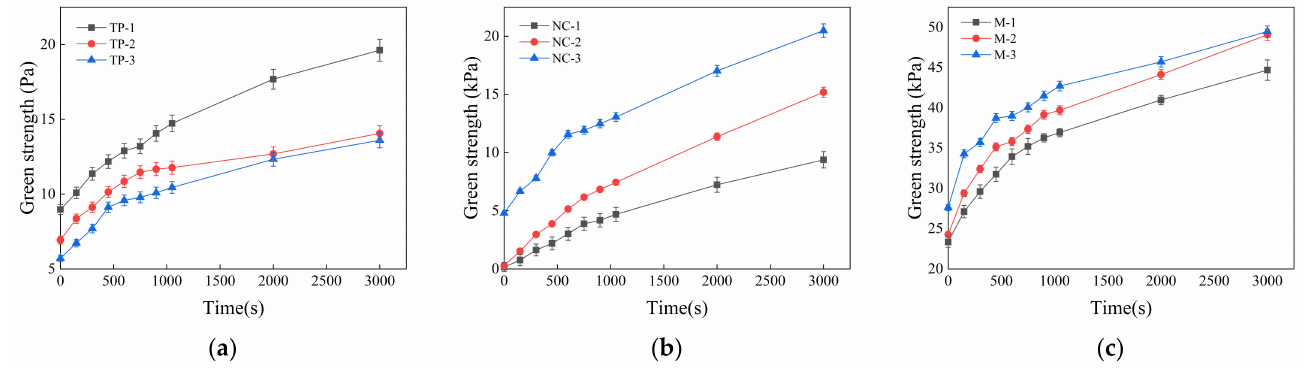
Figure 14. The green strength development with time of printed materials with ( a ) single-doped TP, ( b ) doped NC and 3‰ PCE and ( c ) double-doped TP and NC.